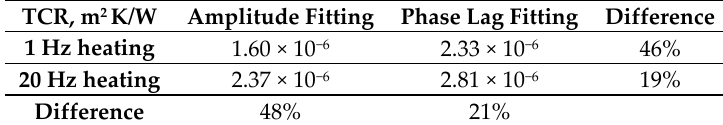
Table 1. Results of fitting analysis of amplitude and phase lag in 1 Hz and 20 Hz